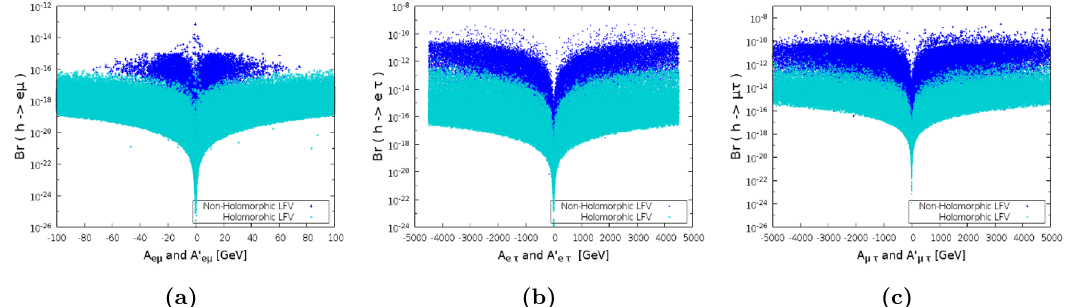
Figure 10. E(cid:11)ect of imposing the LHC constraints on Y ij on the analysis of (cid:12)gure 6: scatter plots of Br ( h e(cid:22) ) with A e(cid:22) and A 0 ! A 0 are shown in (cid:12)gure 10(b). Figure 10(c) is for Br ( h e(cid:28)